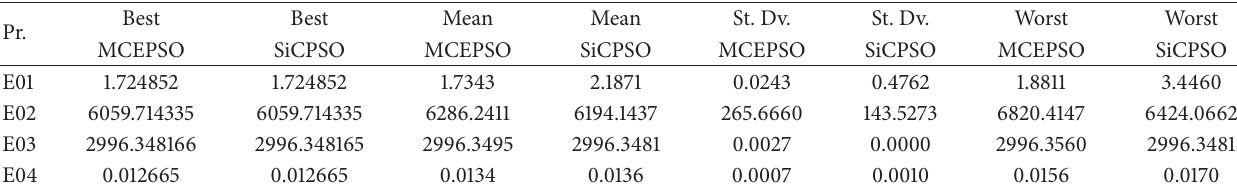
Table 1: FIT: results with 10 particles: 3000 iterations. Statistics over 50 runs.